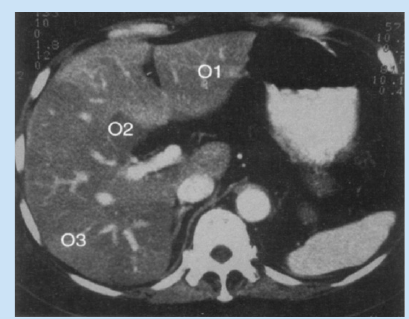
Fig.1b. Contrast-enhanced CT at the same level demonstrates the hepatic and portal vein branch- es passing normally through the regions of fatty